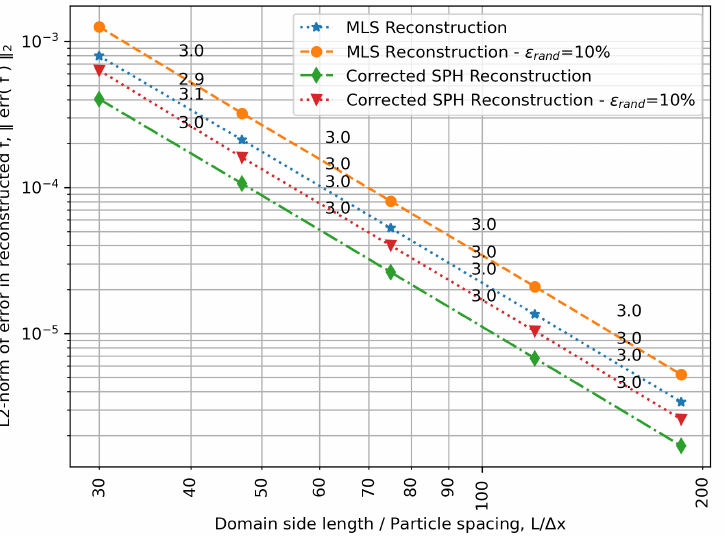
Figure 2. Convergence of the L2 norm of the error in the reconstruction of Equation (20) in the squared domain [ − 1,1 ] × [ − 1,1 ] with side length L = 2 m. Results are displayed for the MLS and for the corrected SPH interpolation methods (with a smoothing length h = 2 ∆ x ), as well as for both uniform and randomized particle distributions. Annotations of the order of convergence are